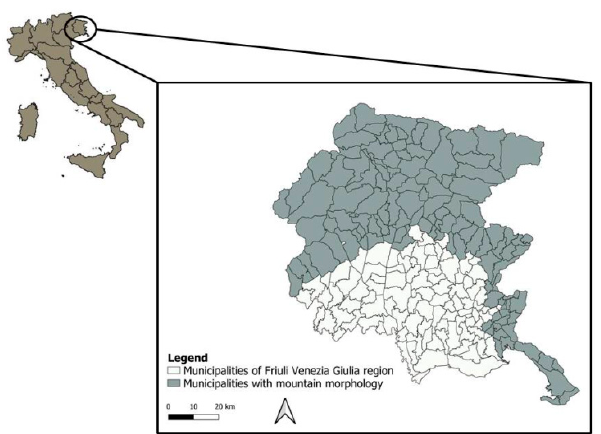
Figure 1. Municipalities of Friuli Venezia Giulia Region with mountain morphology. Source: Direzione Centrale, Commercio, Cooperazione, Risorse agricole e Forestali; Region of Friuli Venezia Giulia (I). Elaborations: authors.